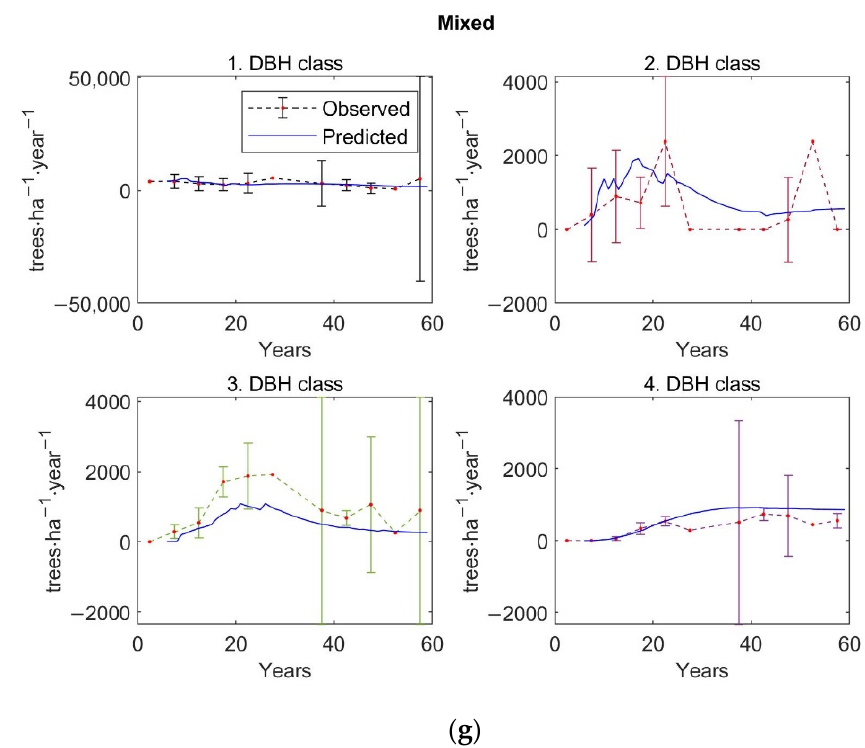
Figure A4. Verification of the model by the comparison of the observed 5-year average values with average predicted values of stem density distributed according to DBH classes, with a 95% confi- dence interval, according to individual forest types: ( a ) alder stand; ( b ) long-lived deciduous stand; ( c ) spontaneous succession; ( d ) larch stand; ( e ) pine stand; ( f ) spruce stand; ( g ) mixed coniferous– deciduous stand.